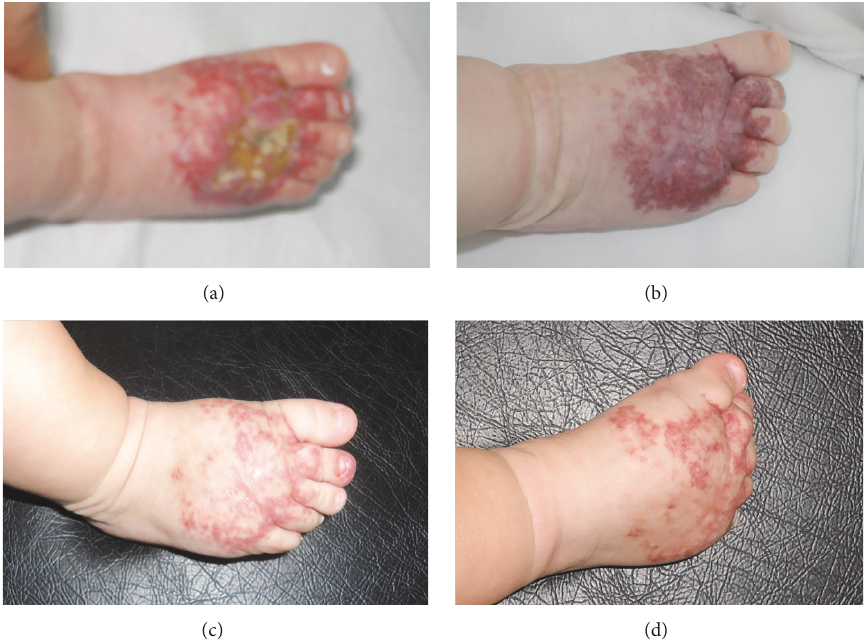
Figure 1: Case 1. (a) Ulceration on an erythematous patch with a network-like and blotchy appearance in the dorsal surface of the foot of a boy of 3 months. (b) Resolution of the ulceration after 1 month with propranolol treatment. Progressive regression of the lesion at 9 months (c) and 11 months